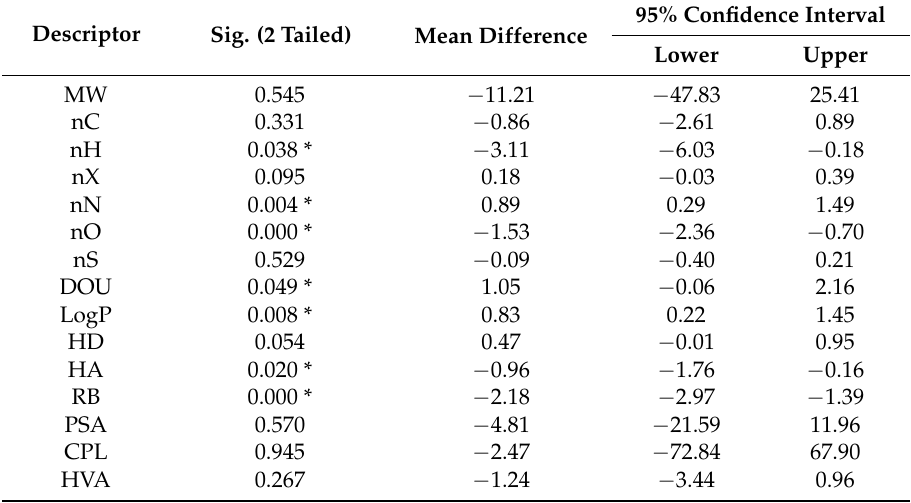
Table 2. Significant structural descriptors for SrtA strong vs. weak